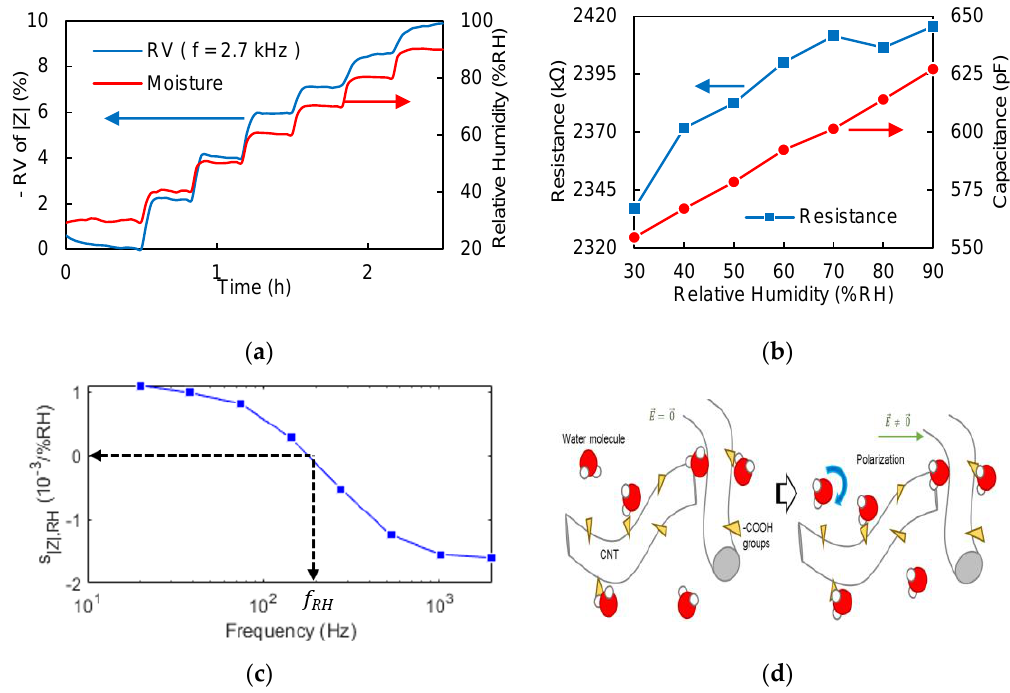
Figure 3. Hygroelectric effect. ( a ) Real-time intermediate-frequency impedance magnitude-time curve during moisture cycle. ( b ) Electrical properties of CNT sensor of different relative humidity values. ( c ) Relative impedance magnitude sensitivity to moisture of different frequencies. ( d ) Schematic diagram of the sensing mechanism of the sensor with moisture changes.